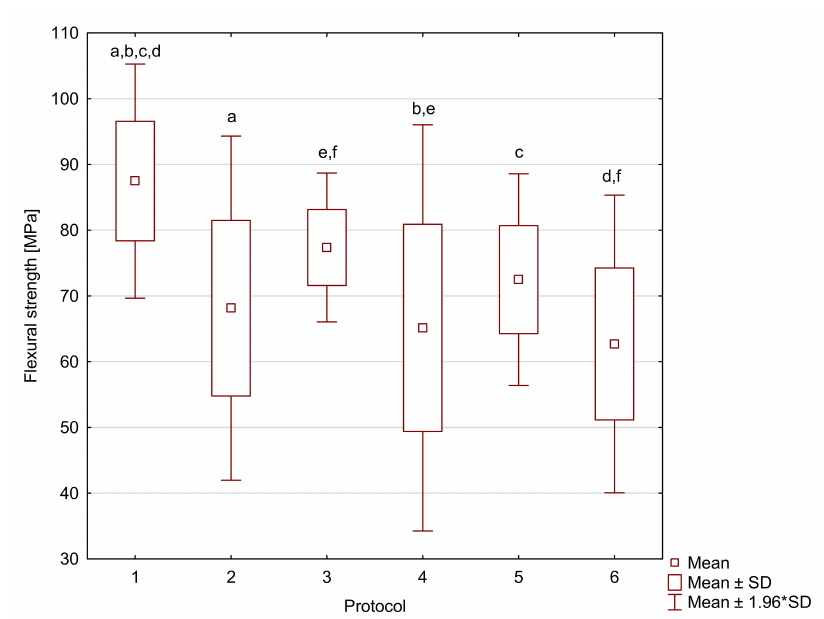
Figure A1. Box-and-whisker plot of three-point bending flexural strength (FS) of Resin F material. Statistically-significant differences were detected between the following: (a,b,c,d) Protocol 1